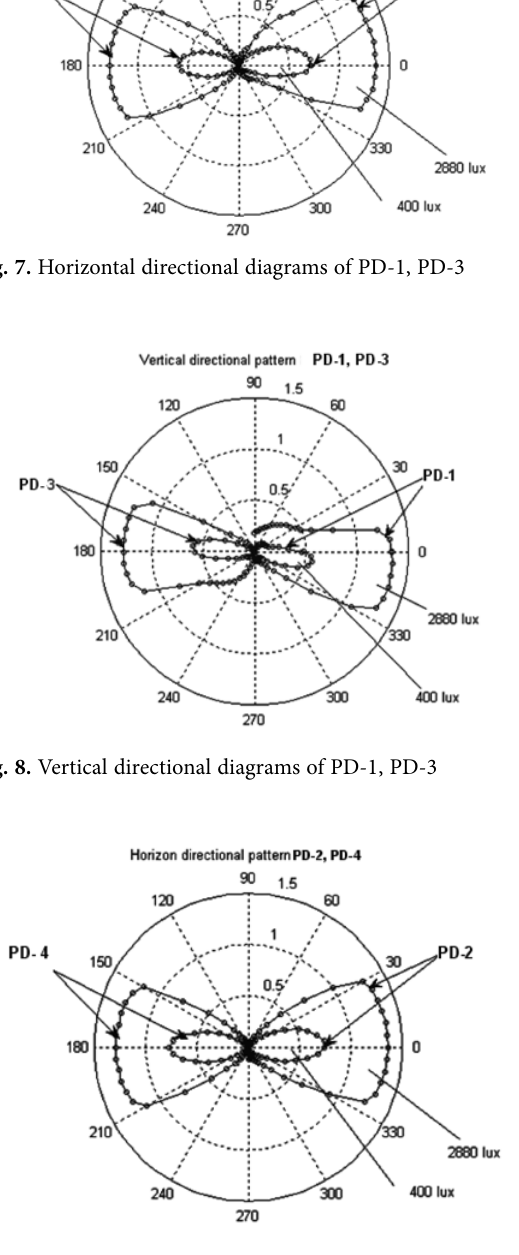
Fig. 9. Horizontal directional diagrams of PD-2, PD-4